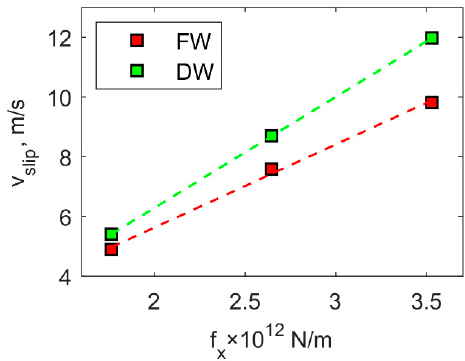
Figure 7. Slip velocity as a function of the magnitude of flow inducing force in FW and DW simula- tions. Table 3. The slip velocity function (Equation (6)) coefficient values for FW and DW simulations. Coeffiicients